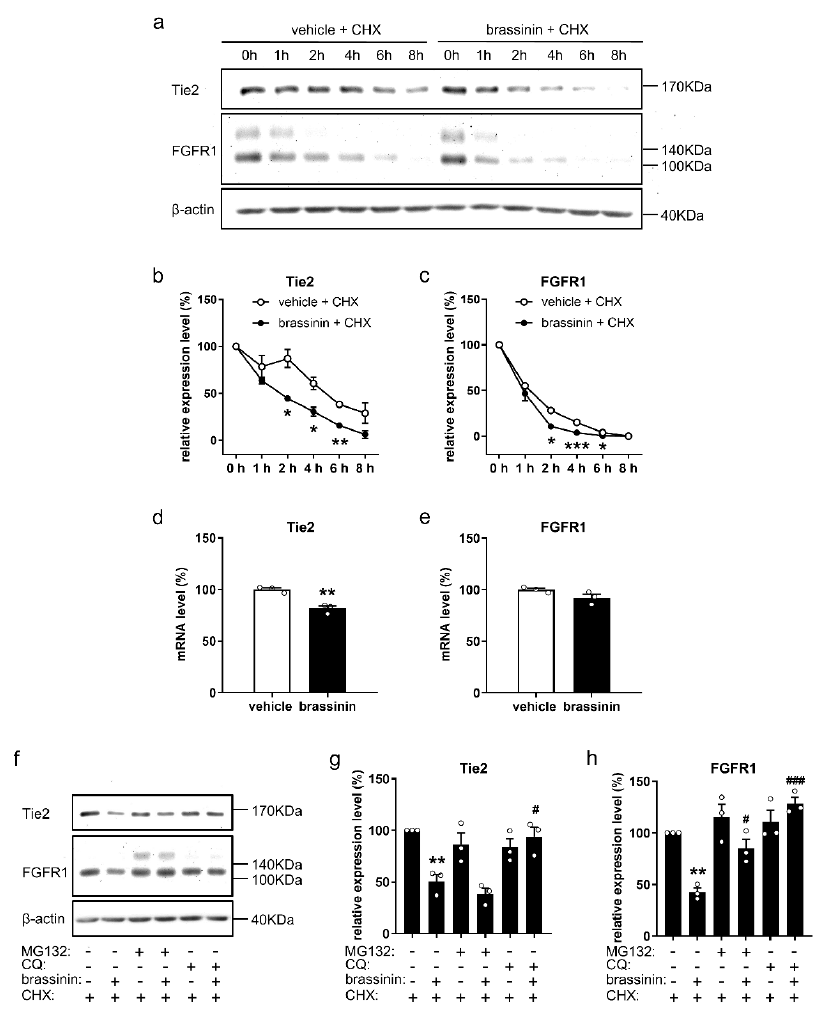
Figure 6. Brassinin promotes Tie2 and FGFR1 degradation in ECs. ( a ) Representative Western blots of Tie2, FGFR1, and β -actin expressed in HUVECs that were treated with 100 µM brassinin or DMSO (0.1% v / v ; vehicle) in the presence of 100 µM CHX for the indicated time periods. ( b , c ) Expression levels (% of 0 h) of Tie2 ( b ) and FGFR1 ( c ) in treated HUVECs were quantified ( n = 3). ( d , e ) mRNA levels (% of vehicle) of Tie2 ( d ) and FGFR1 ( e ) in HUVECs that were treated for 2 h with 100 µM brassinin or DMSO (0.1% v/v ; vehicle) were assessed by quantitative real-time PCR ( n = 3). ( f ) Representative Western blots of Tie2, FGFR1, and β -actin expressed in HUVECs that were pretreated without or with 20 µM MG132 or 200 µM CQ for 2 h and then exposed to 100 µM brassinin or DMSO (0.1% v/v ; vehicle) in the presence of 100 µM CHX for another 2 h. ( g , h ) Expression levels (% of vehicle) of Tie2 ( g ) or FGFR1 ( h ) in treated HUVECs were quantified ( n = 3). Means ± SEM. * p < 0.05, ** p < 0.01, *** p < 0.001 vs. vehicle or ‘vehicle + CHX’. # p < 0.05, ### p < 0.001 vs. ‘brassinin + CHX’.